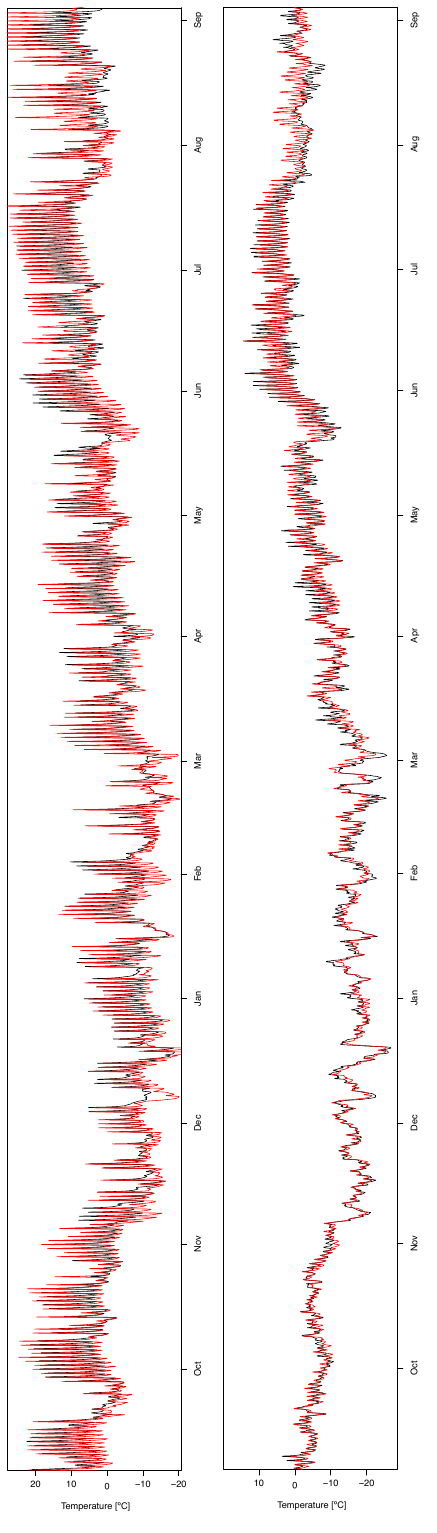
Figure 3. Temperature in complex topography: comparison of mea- sured (red line) and simulated (black line) results at Jungfrau ridge south (left) and north (right) during year 2005/2006. Measured data are taken from PERMOS